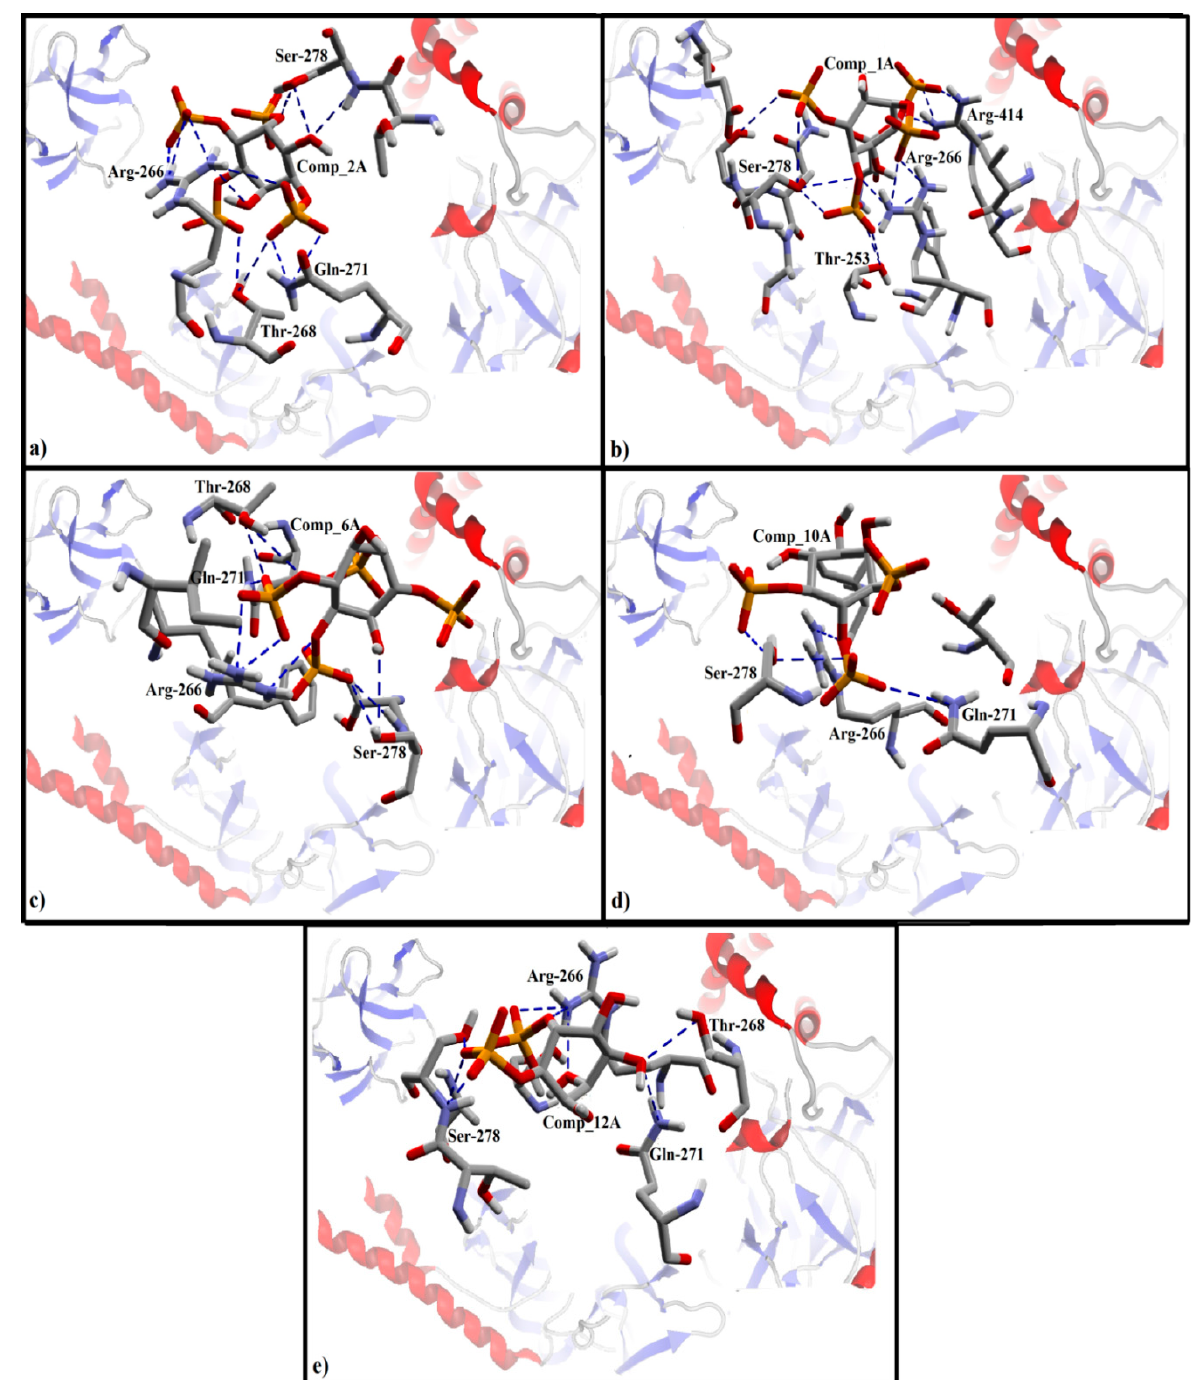
Figure 4. The ligand-protein interactions of docking solutions of class A in the binding pocket of IP 3 R. The backbone of protein is represented as a secondary structure. The interacting residues are shown in stick form with elements colors scheme. ( a ). Finally selected docked pose of 2Ain the binding pocket of IP 3 R showing hydrogen bond acceptor interactions with Arg-266, Thr-268, and Ser-278. ( b ). The final docked pose of 1A in the binding pocket of IP 3 R showing hydrogen bond interactions with Arg-266, Thr-268, Ser-278, and Arg-414. ( c ). The docked pose of 6A in the binding pocket of IP 3 R is showing hydrogen bond interactions with Arg-266, Thr-268, and Ser-278. ( d ). Final docked pose of 10A in the binding pocket of IP 3 R showing hydrogen bond interactions with Arg-266, and Ser-278. ( e ). Final docked pose of12A in the binding pocket of IP 3 R showing hydrogen bond interaction with Arg-266, Thr-268, and Ser-278.